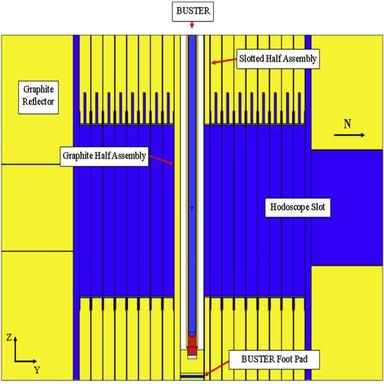
Vertical Plot (YZ-Plane) of BUSTER Loaded into the TREAT Experiment Slot for the Full-Slotted Core Conguration.